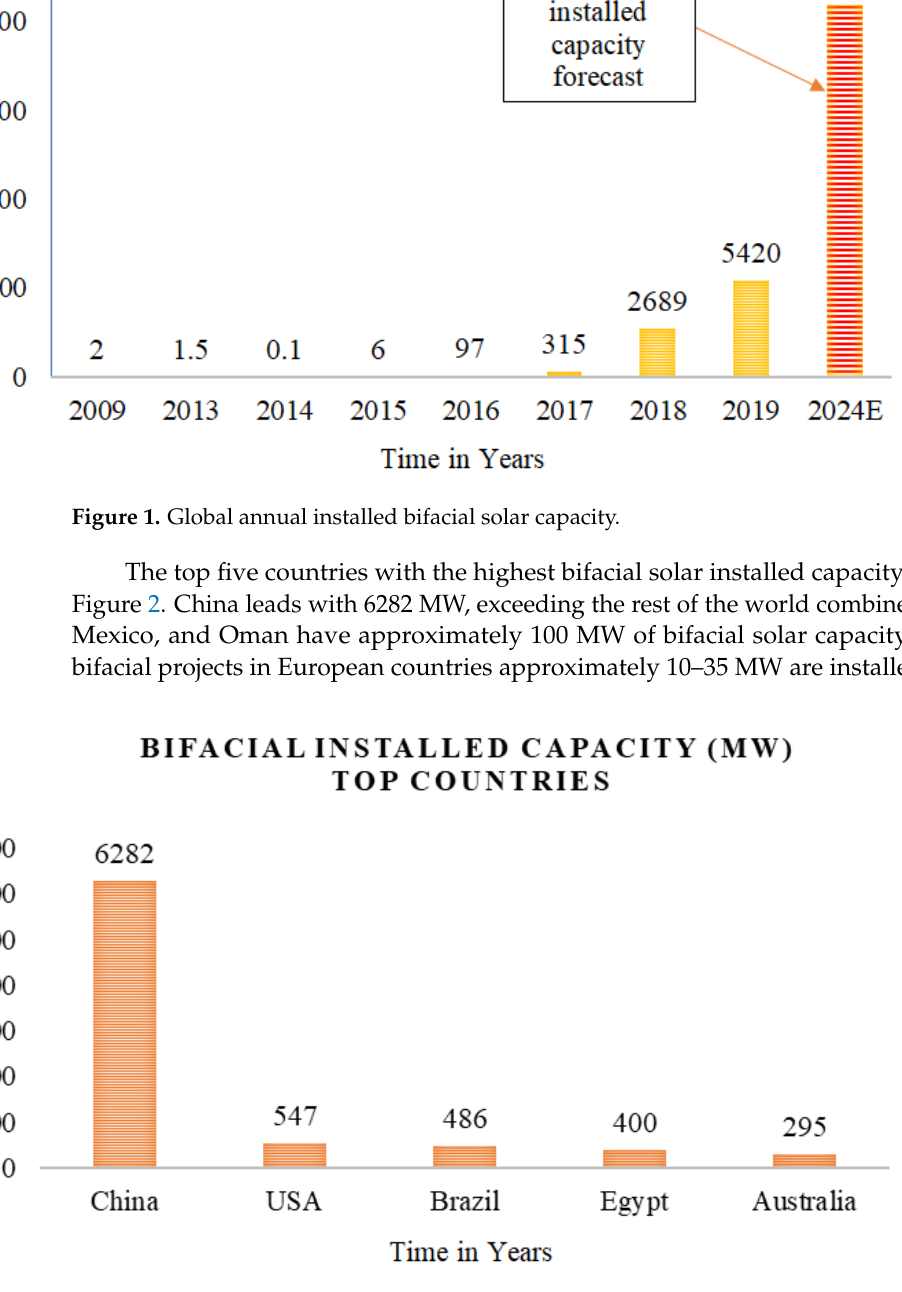
Figure 2. Top five countries with the highest bifacial solar installed capacity. The PV inverters in bifacial PV panels operate at nearly the rated power for a more extended period. This increases the thermal stress upon the PV inverter, which